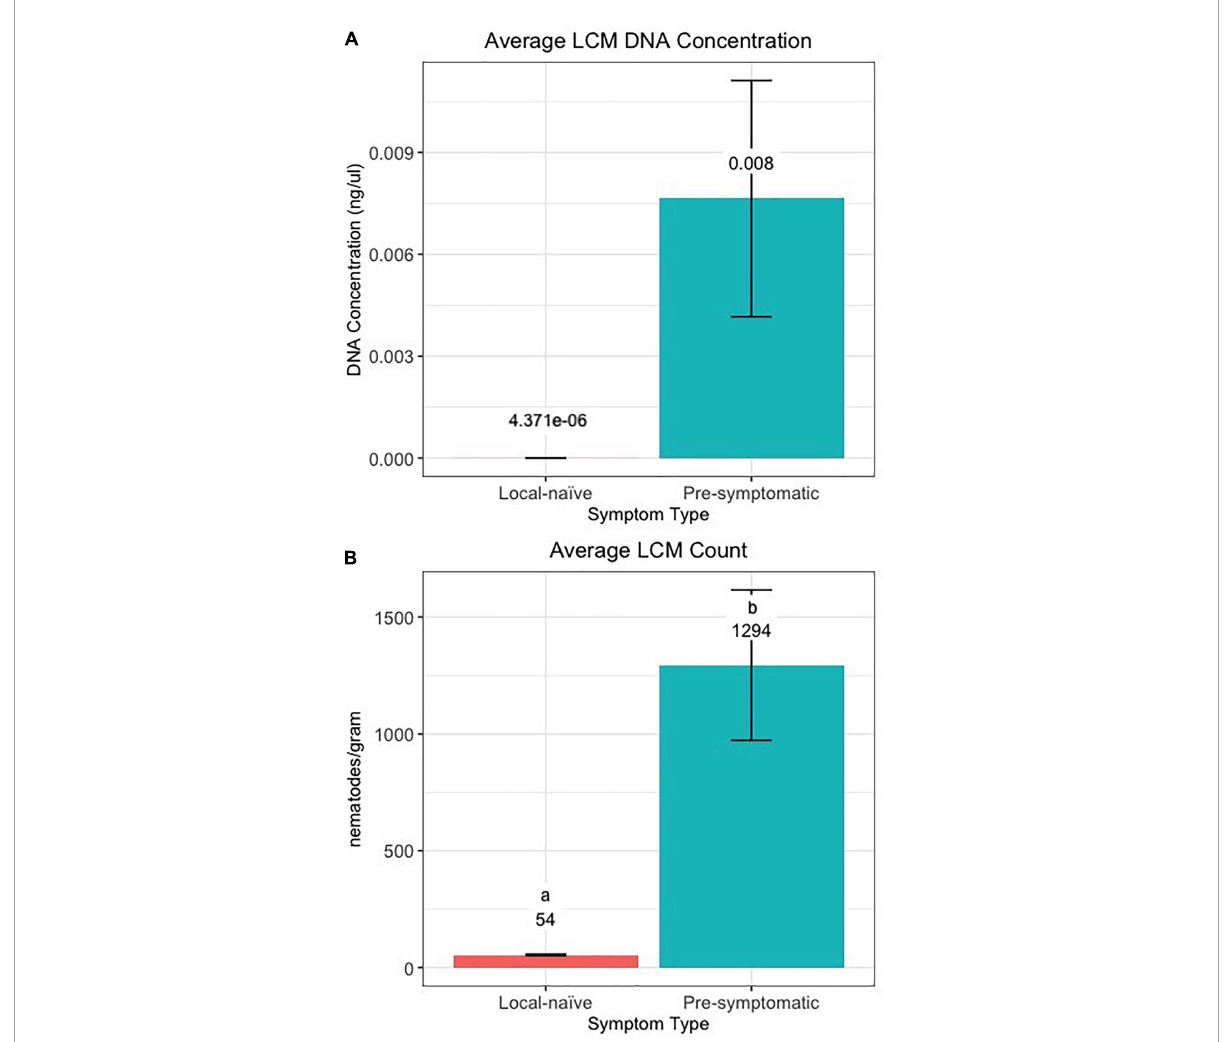
FIGURE8 (A) DNA concentration and (B) count of Litylenchus crenatae mccannii (LCM) in local-naïve samples and pre-symptomatic samples from only the Kiwanis site. Actual concentration and nematode counts are listed above the bars and significant differences ( p < 0.05) between symptom types are represented by different